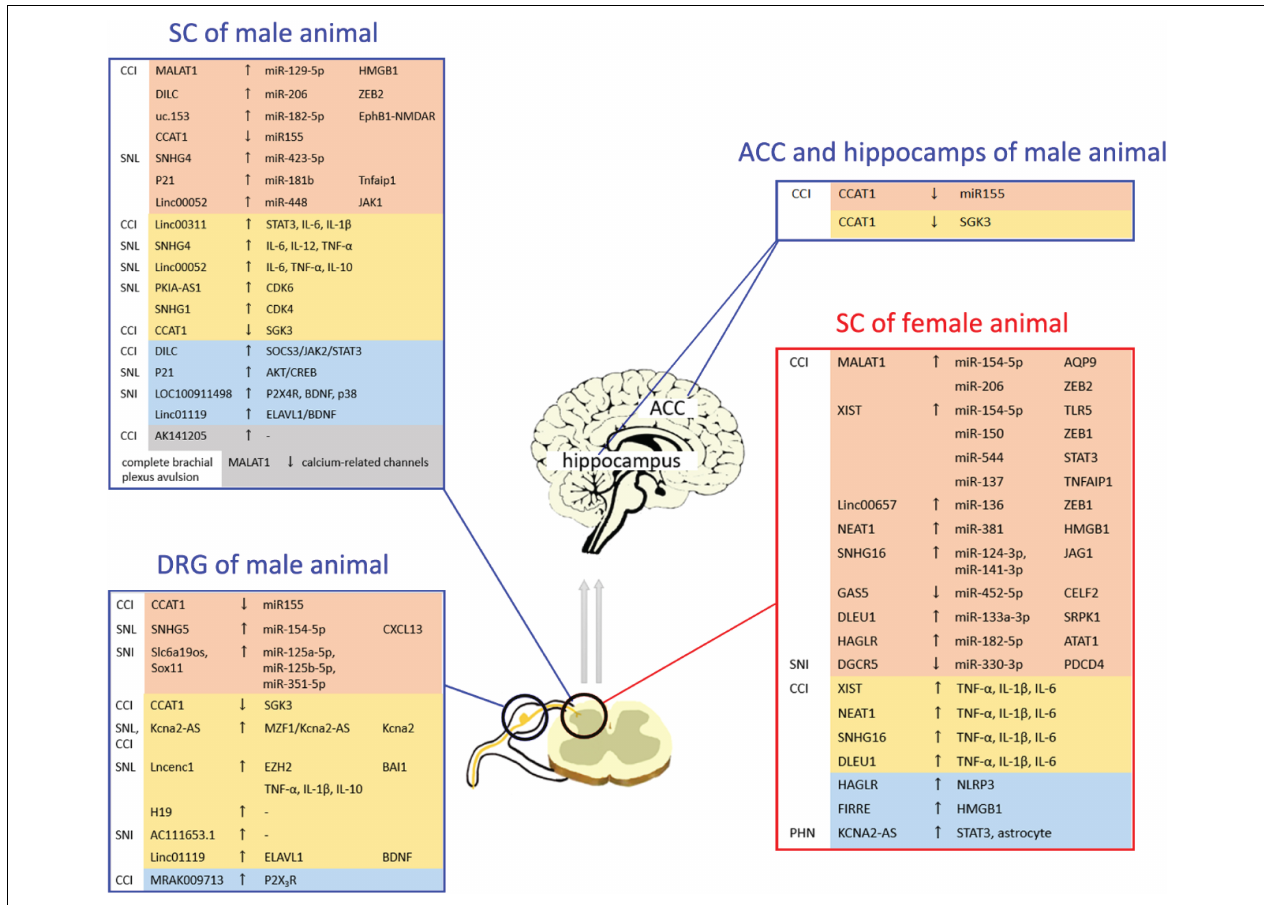
FIGURE 2 | Distribution of deregulated long non-coding RNAs (lncRNAs) with the respective associated mechanisms in peripheral nerve injury (PNI): lncRNAs can participate in the development of PNI-induced chronic neuropathic pain (CNP) through various mechanisms. The same lncRNA displays different expressions in different models or issues. Most lncRNAs can play an important role in the development of PNI-induced CNP in both female and male models. ACC, anterior cingulate cortex; DRG, dorsal root ganglion; SC, spinal